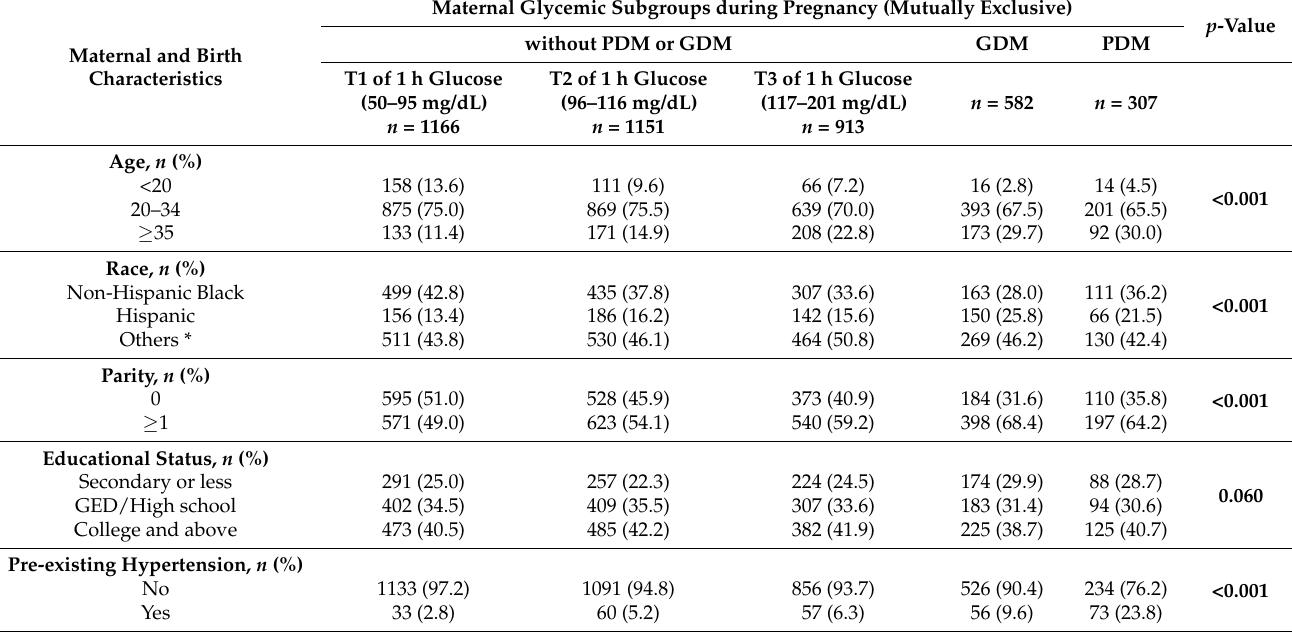
Table 1. Comparison of Maternal and Birth Characteristics Between the Maternal Glycemic